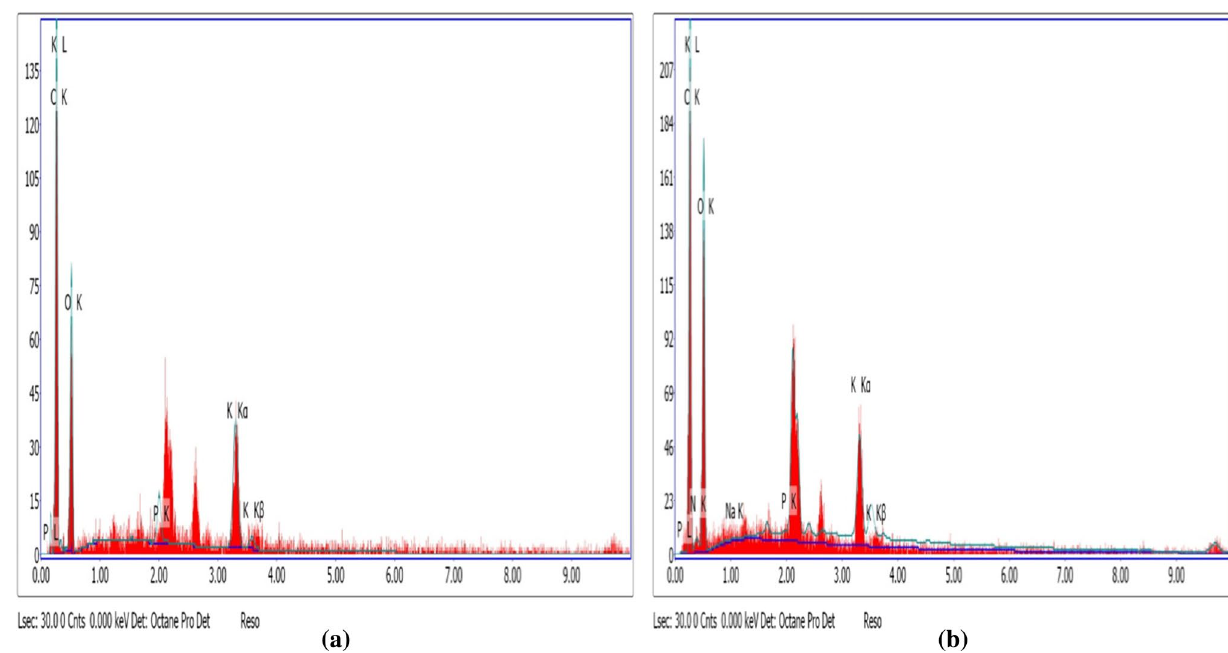
Fig. 6 a EDX analysis of Eichhornia crassipes steam unloaded with phenol and cyanide and b loaded with phenol and cyanide